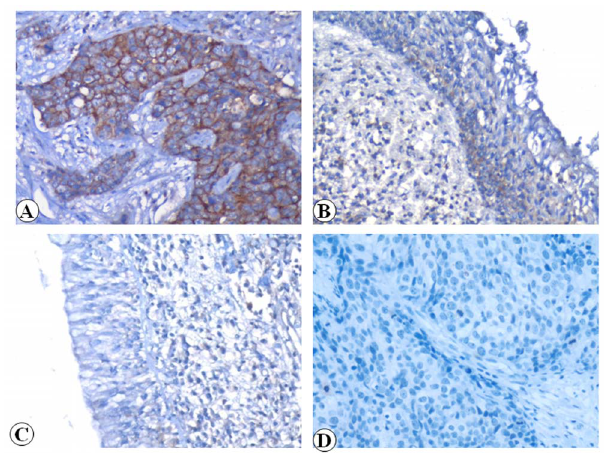
Figure 1. Expression of Flot-2 protein in NPC, atypical hyperplasia epithelial cells and control nasopharyngeal epi- thelial cells was detected by IHC. The expression of Flot-2 protein was detected by immunohistochemistry using specific antibody as described in the section of materials and methods. Strong positive expression of Flot-2 protein was found in NPC cell membranes (Fig 1A, 20 6 , IHC, DAB staining). Weak Flot-2 membrane-staining was showed in the atypical hyperplasia epithelial cells (Fig 1B, 20 6 , IHC, DAB staining). Negative staining of Flot-2 was showed that in the control nasopha- ryngeal epithelial cells (Fig 1C, 20 6 , IHC, DAB staining). Negative control showed no Flot-2 staining in the NPC cells (Fig 1D, 20 6 , IHC, DAB staining).